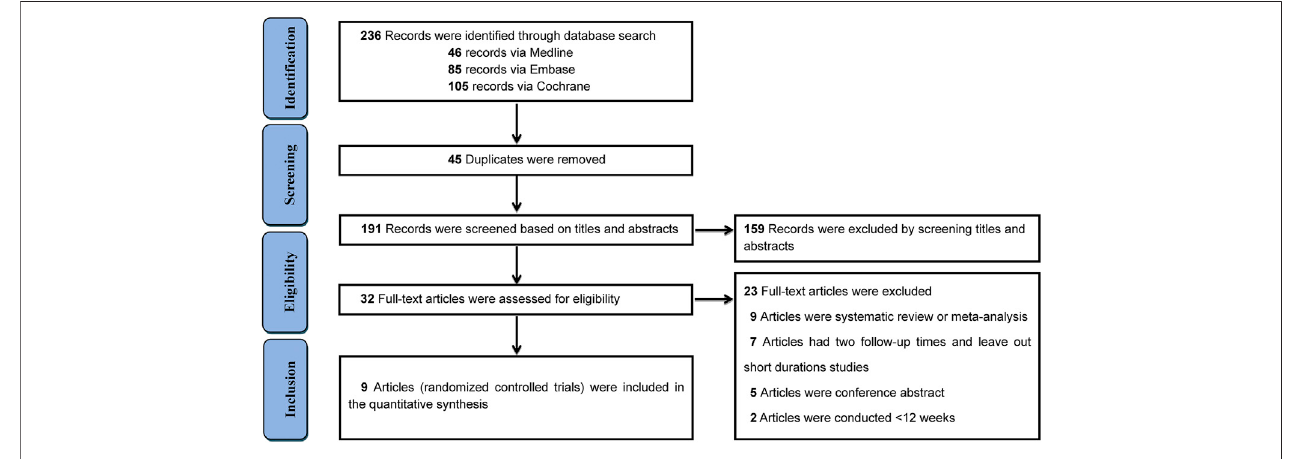
FIGURE 1 | PRISMA diagram of the selection of eligible randomized controlled